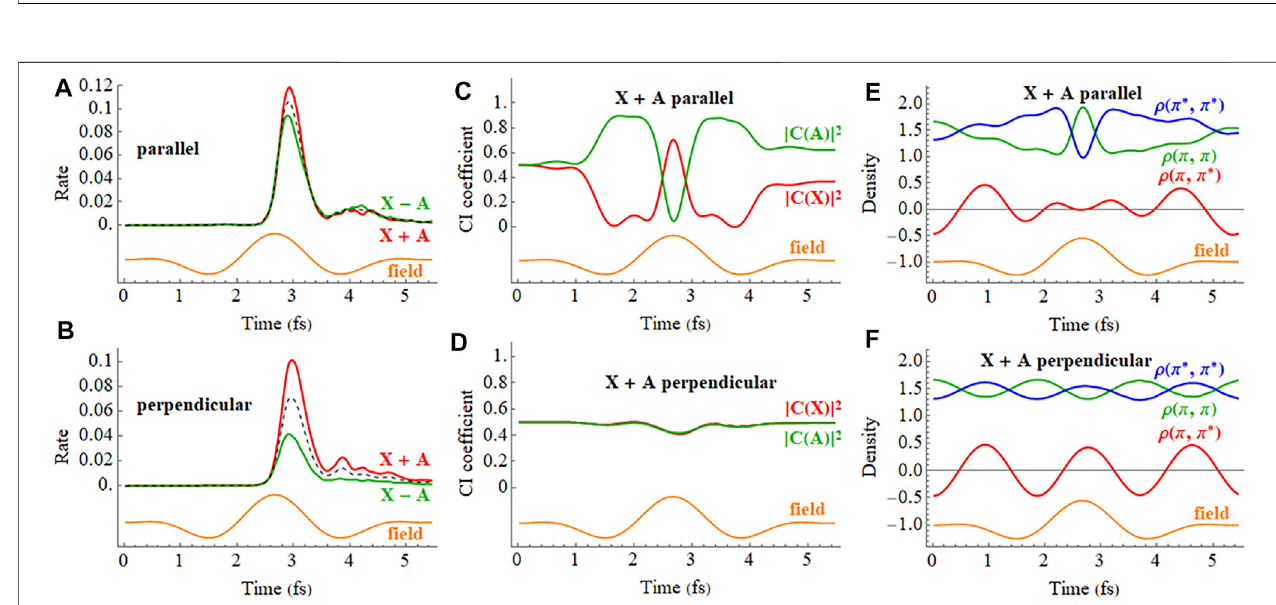
FIGURE 9 | (A,B) Ionization rate for the X and A cations in a 2 cycle linearly polarized 800 nm pulse with E max = 0.075 au aligned parallel and perpendicular to the molecularaxis(Xinred,Aingreen). (C,D) CIcoef fi cientsfortheXand Acon fi gurations (redand green,resp.)inthenormalizedwavefunctionsfortheX( (cid:2) π p − 1 x )andA( (cid:2) π − 1 x ) states with the pulse aligned parallel to the molecular axis with ionization mainly from the iodine. (E,F) Density matrix elements for the π x and π p x orbitals in the X and A statesforthepulsealignedwiththemolecularaxis(theorangetracesareproportionaltotheelectric fi eld).Amovieoftheholedensityisavailablein Supplementary Figure S3 of the Supporting Information.